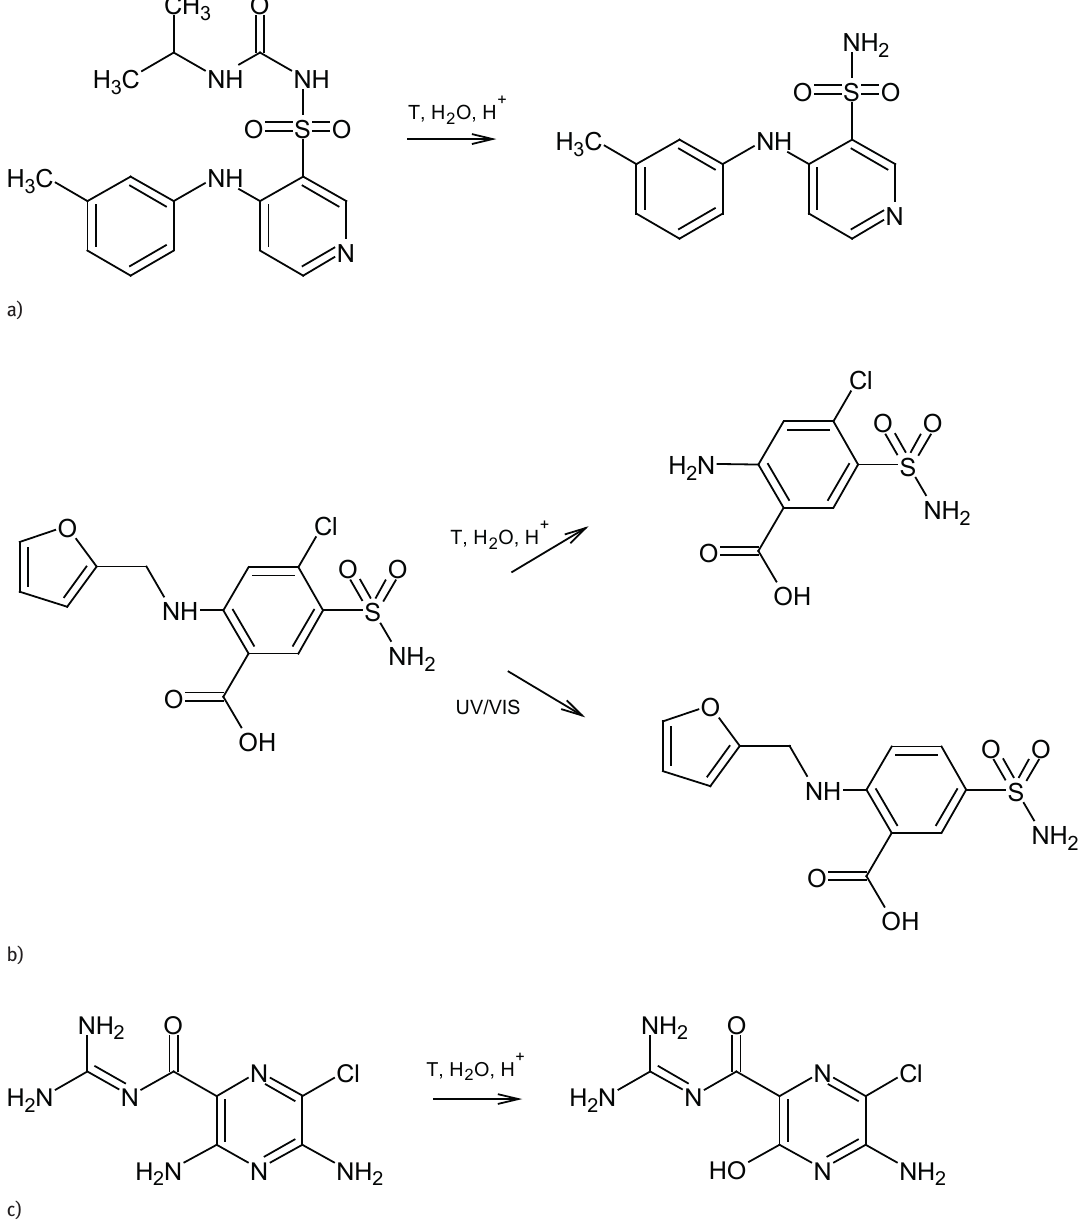
Figure 8 : Hypothetical degradation pathways of torasemide (a), furosemide (b, c) and amiloride (d) influenced by operative excipients or stress